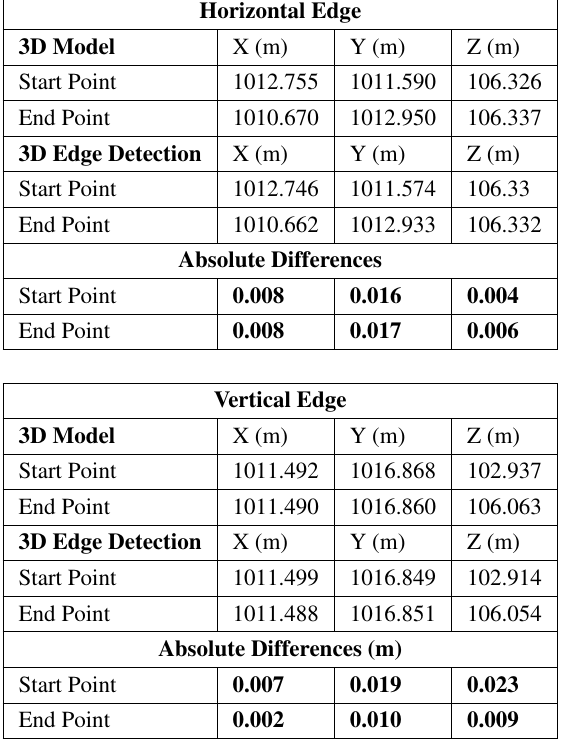
Table 1. Start point and end point comparison